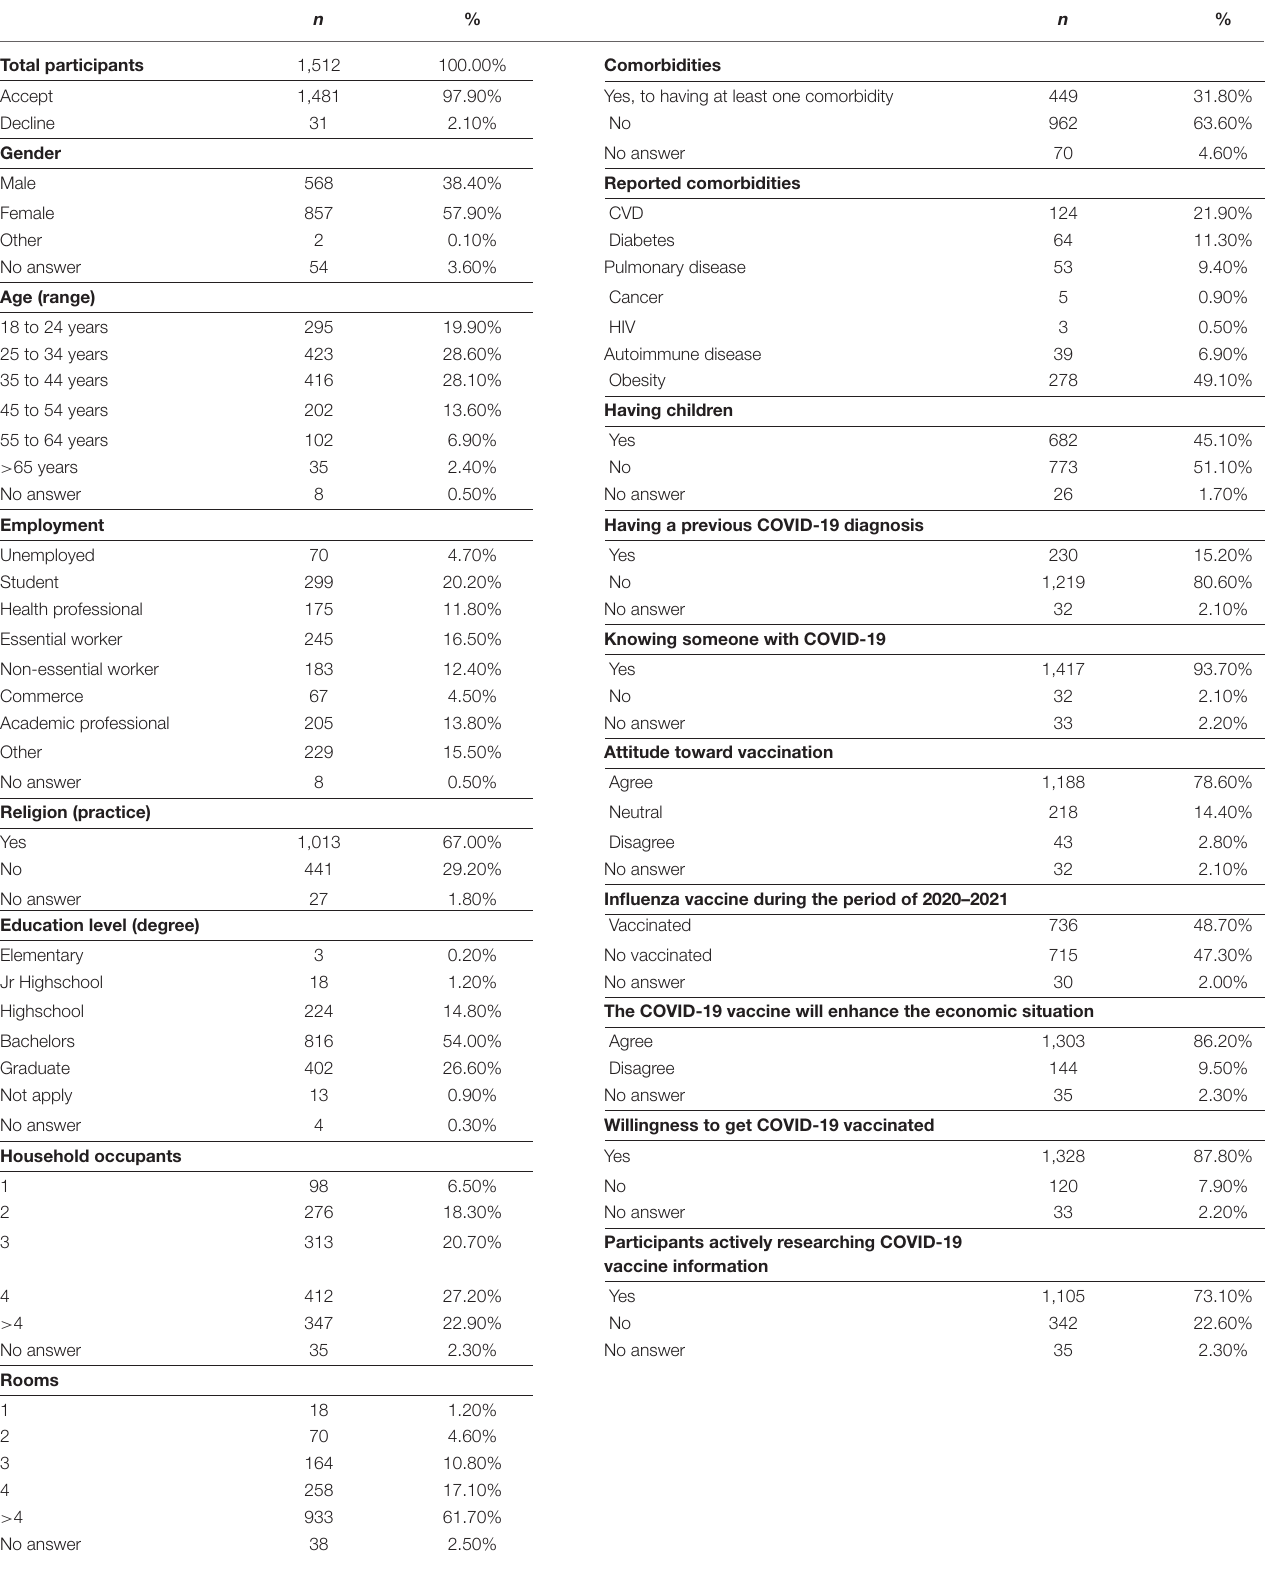
TABLE 2 | Social demographic profiles of